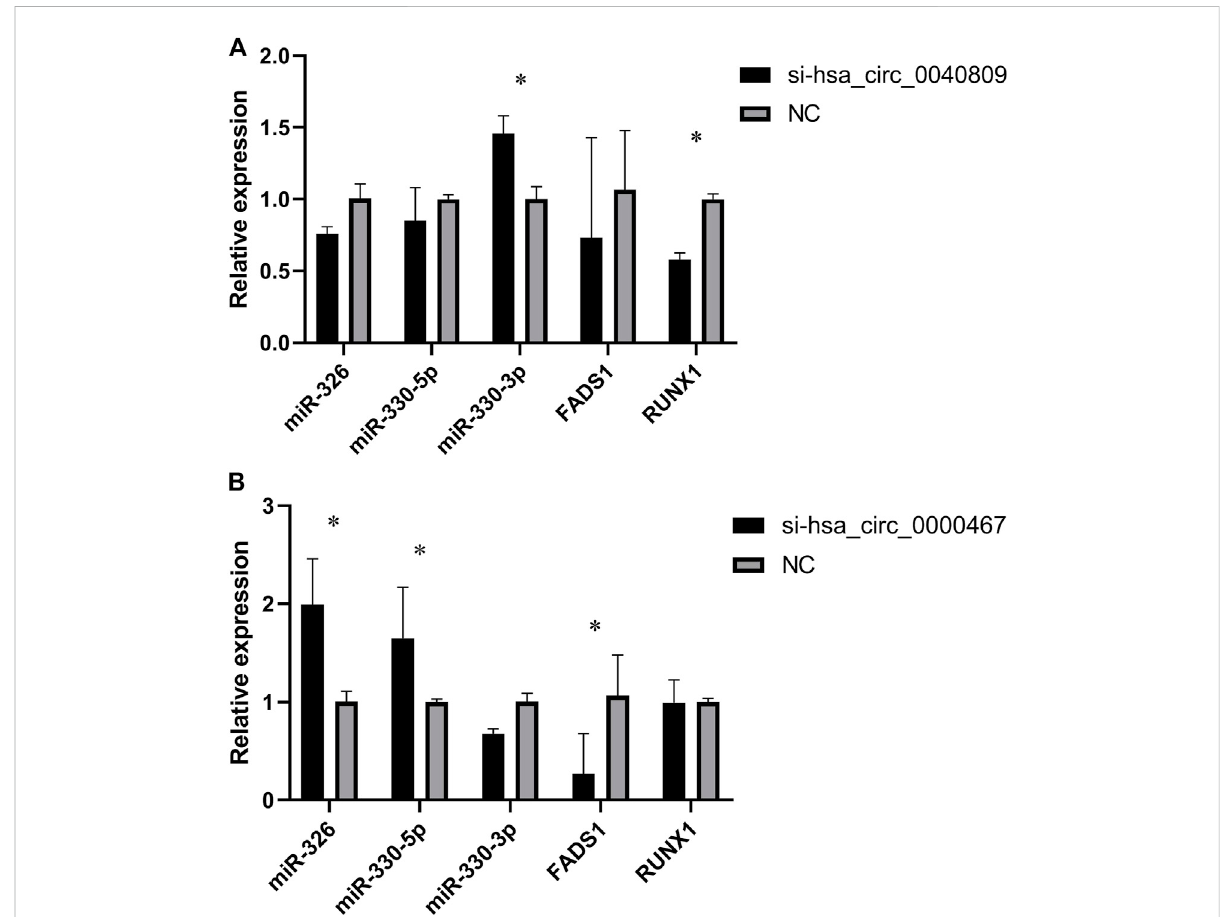
FIGURE 5 The expression of miRNAs and mRNA in knockdown of hsa_circ_0040809 and hsa_circ_0000467 CRC cells. (A) The relative expressions of miR-330-3p, miR-330-5p, miR-375, FADS1 and RUNX1 in knockdown of hsa_circ_0040809 CRC cells. (B) The relative expressions of miR-330-3p, miR-330-5p, miR-375, FADS1 , and RUNX1 in knockdown of hsa_circ_0000467 CRC